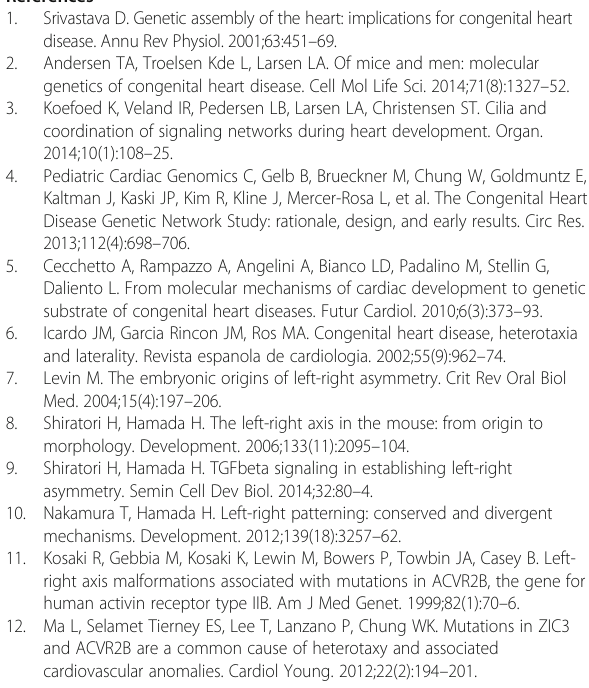
Additional file 1: Figure S1. Luciferase assay with a dose response for the mutant protein versus the wild type protein. The results confirm the decrease in the DAND5 protein activity when compared the DAND5 variant with the wild-type DAND5 protein at three different concentrations. Additional file 2: Figure S2. Luciferase assay with a dose response for the mutant protein versus the wild type protein. The results confirm the decrease in the DAND5 protein activity when compared the DAND5 variant with the wild-type DAND5 protein at three different concentrations. Additional file 3: Figure S3. Western Blot of mouse wild-type and mouse variant DAND5/Cerl2 protein. Since the available antibodies against human DAND5/Cerl2 are not specific enough to detect the human protein, we performed a western blot assay using lysates of cells transfected with the mouse DAND5/Cerl2 WT and DAND5/Cerl2 variant proteins, and no difference was observed in the protein production. Curiously, the conditioned medium of the same cells showed a higher accumulation of the DAND5/Cerl2 variant protein when compared to the DAND5/Cerl2 WT protein. CM – conditioned media; Mut – Mutant protein; WT – wild-type protein. (TIFF 2995